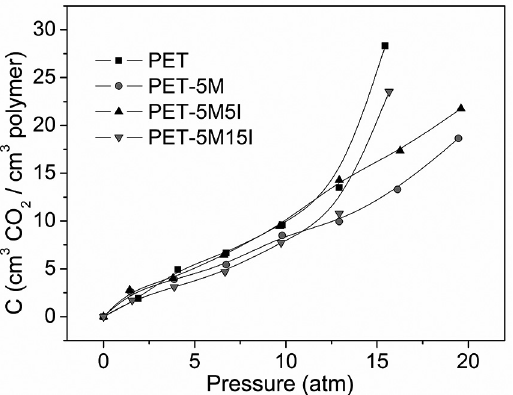
sorption isotherms at 35°C for the neat PET and its Figure 4. CO 2 nanocomposites containing 5 wt% of the